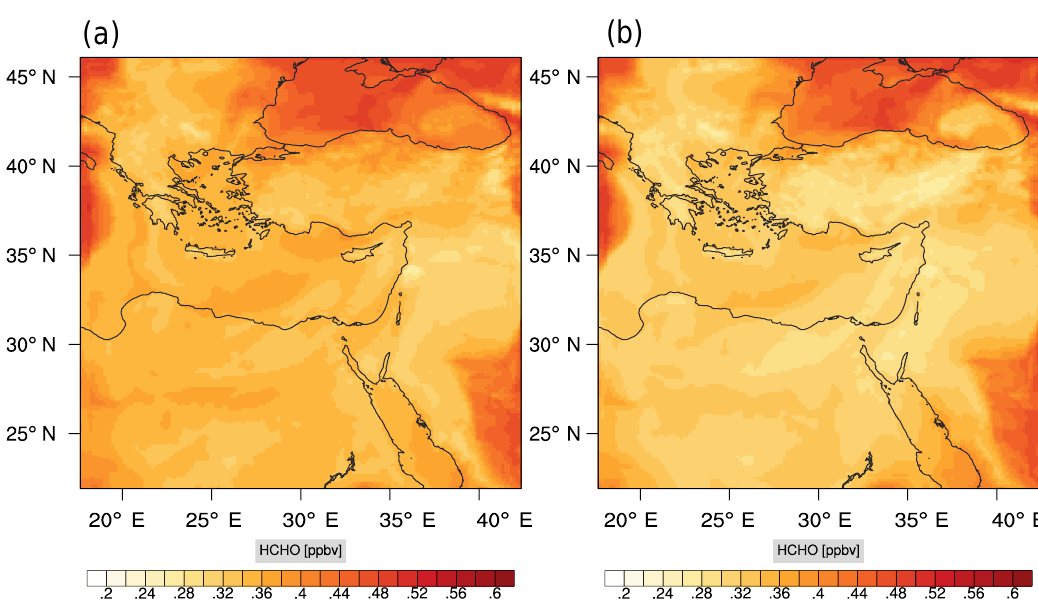
Figure 11. Instantaneous comparison of the formaldehyde spatial mixing ratio, averaged over the first nine vertical layers, using the full mechanism (a) and the skeletal mechanism (b) .